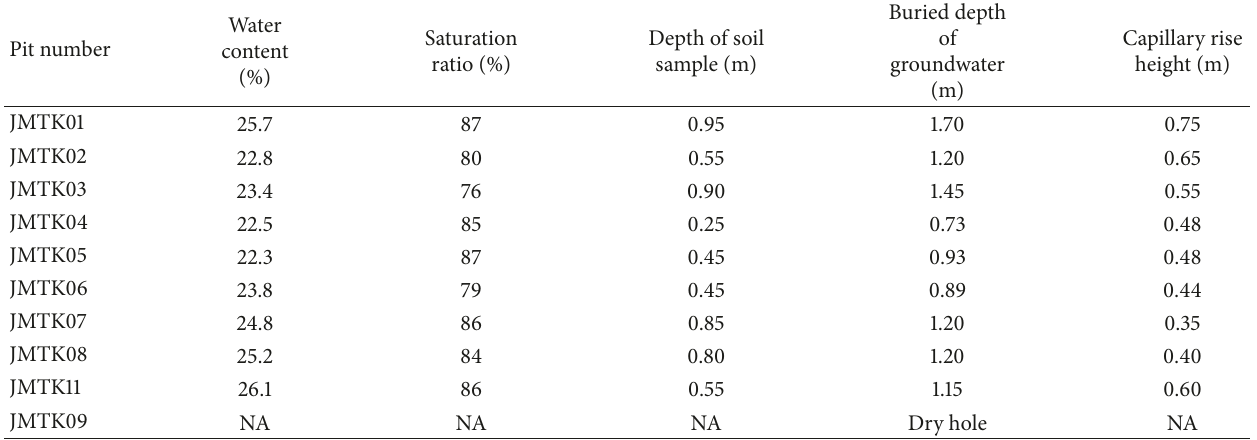
Table 2: Calculation results of capillary rise height in each exploration pit